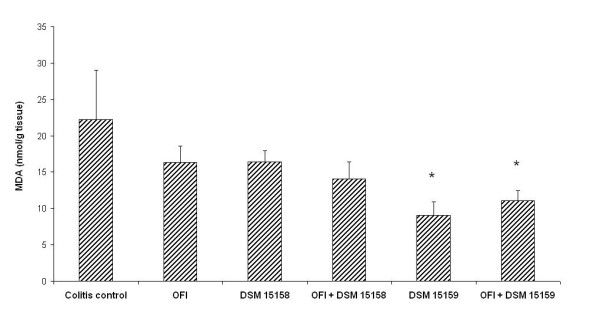
Malondialdehyde (MDA) concentration in the colon (nmol/g tissue). * denotes p < 0.05 compared to colitis control.